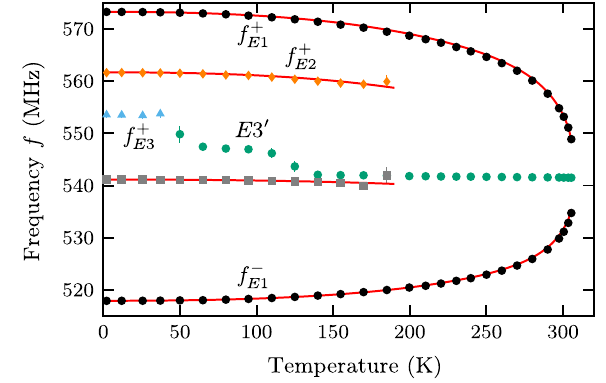
FIG. 6. Temperature dependence of frequencies obtained in B ¼ 4 T jj c . Solid lines are calculated doublet frequencies ext ð T Þ and f (cid:4) ð T Þ assuming constant θ f (cid:4) E 1 E 2